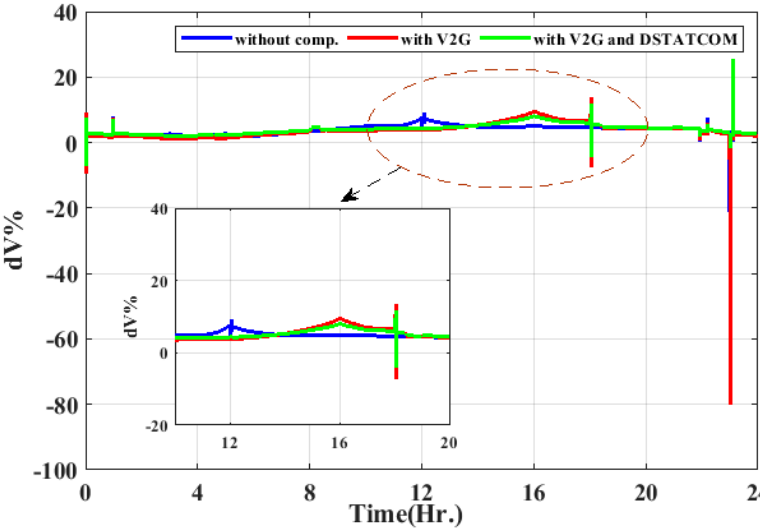
Figure 15. Load Voltage deviation for the three case studies.